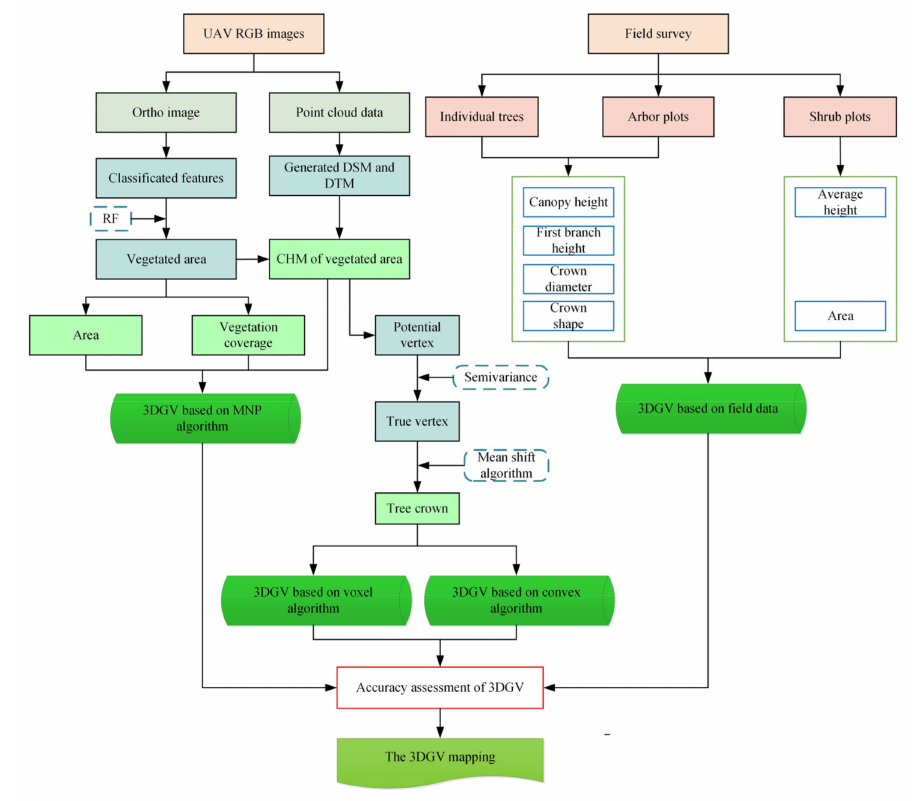
Figure 1. Workflow for 3DGV estimation based on UAV RGB